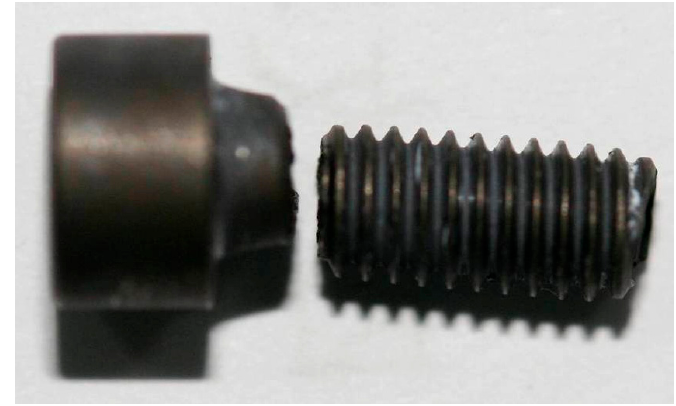
Figure 1. Fracture position of screw.